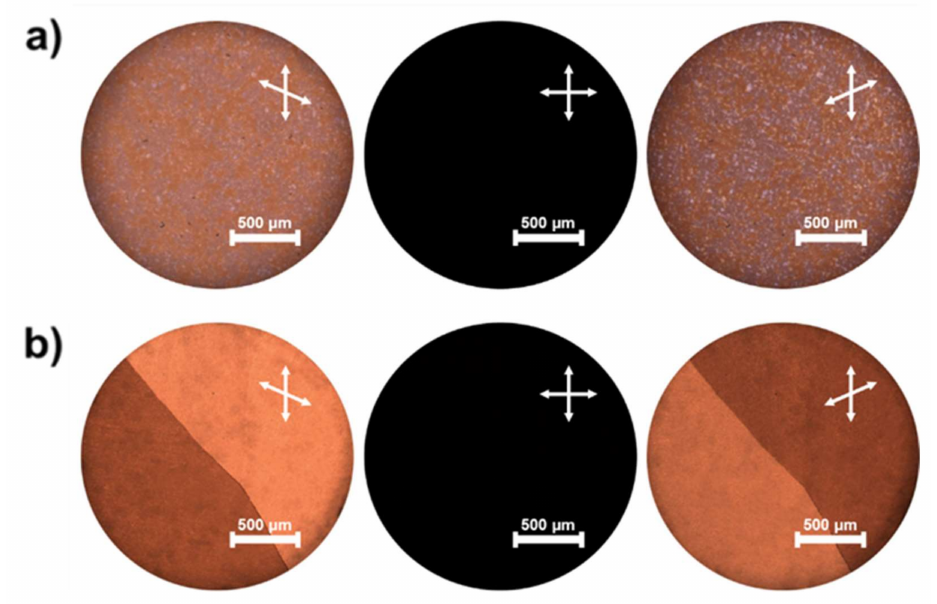
Figure 1. Typical polarized optical microscopy (POM) image in: ( a ) B4 phase of bent-core (BC) molecule (P-9) and in ( b ) B4 phase blended with a rod-like liquid crystal (LC) molecule (5PCB). (Mixing ratio: 55 wt% P-9 and 45 wt%